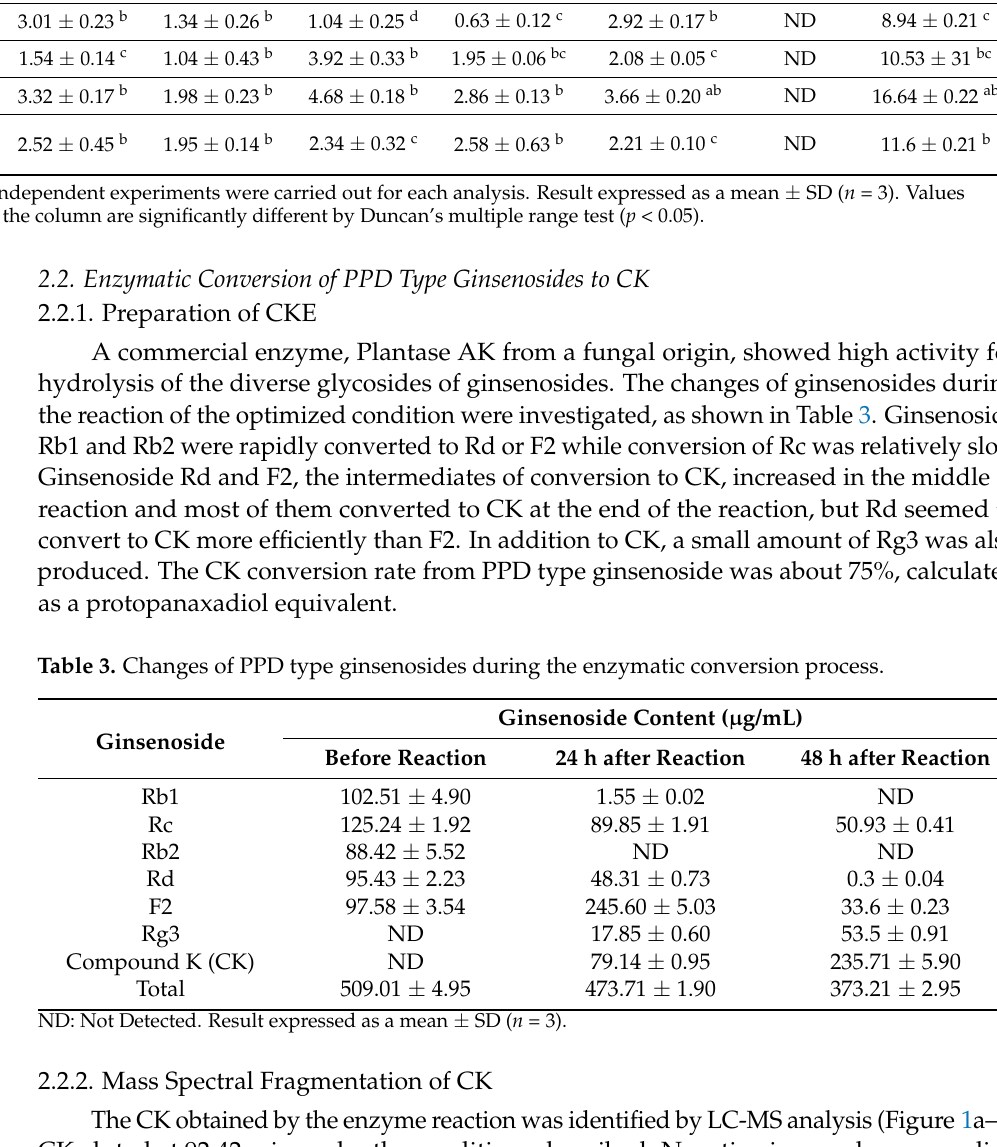
Table 2. Protopanaxadiol (PPD) type ginsenoside composition in ginseng sprout and 6-year-old ginseng root. Test Group